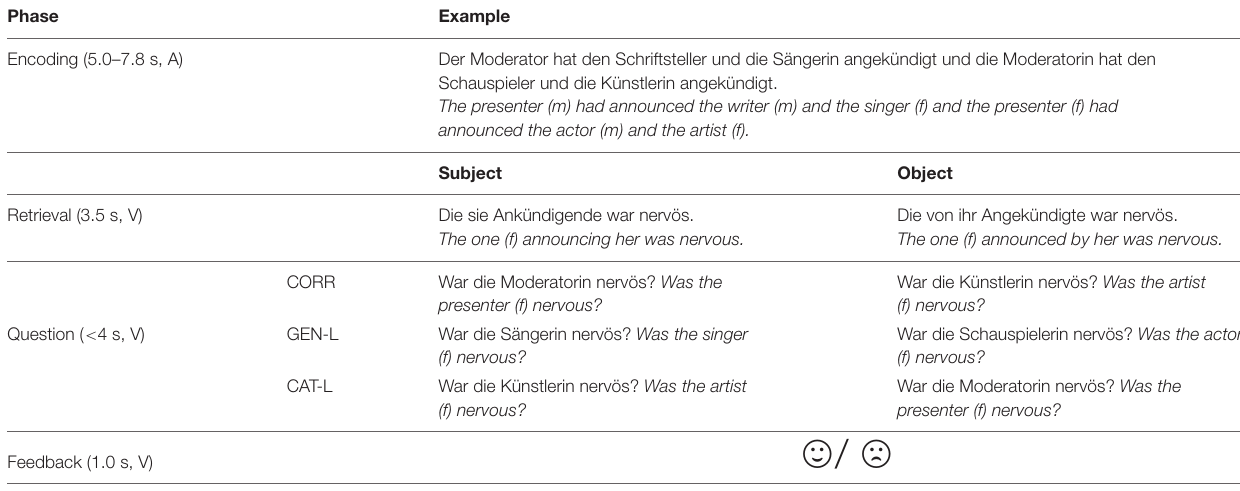
TABLE 2 | Experimental design; examples of encoding sentence, retrieval sentence (requiring retrieval of either subject or object), comprehension question, and feedback [this table is adapted from Beese et al. (2017)]. Phase Example Encoding (5.0–7.8 s,